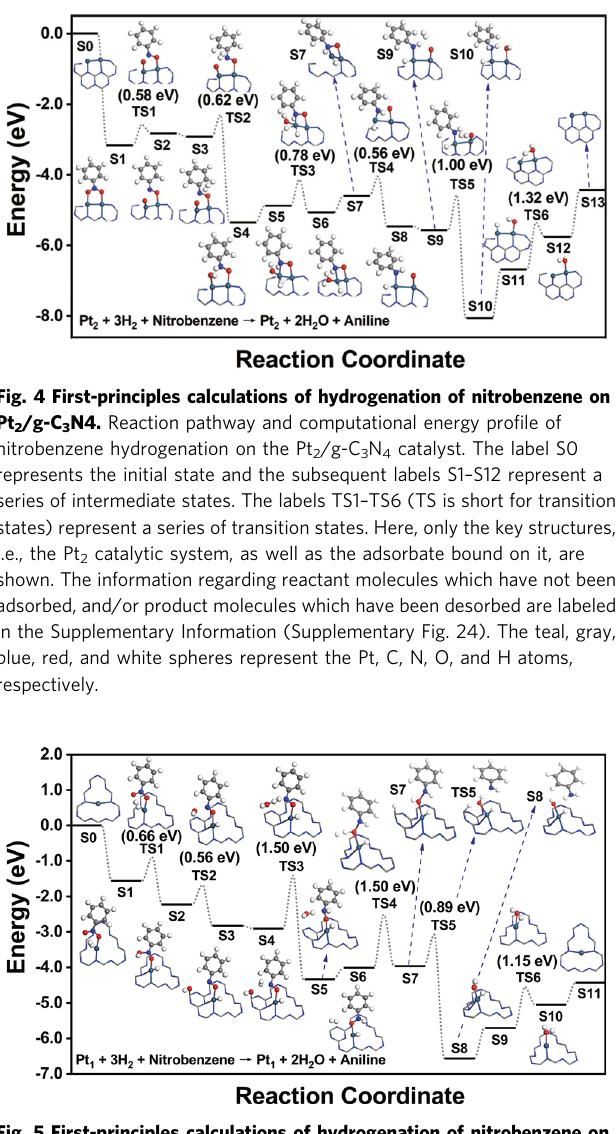
Fig. 5 First-principles calculations of hydrogenation of nitrobenzene on Pt 1 /g-C 3 N4. Reaction pathway and computational energy pro fi le of nitrobenzene hydrogenation on the Pt 1 /g-C 3 N 4 system. The label S0 represents the initial state and the subsequent labels S1 – S10 represent a series of intermediate states. The labels TS1 – TS6 (TS is short for transition states) represent a series of transition states. Here, only the key structures, i.e., the Pt 1 catalytic system as well as the adsorbate bound on it, are shown. The information regarding reactant molecules which have not been adsorbed, and/or product molecules which have been desorbed are labeled in the Supplementary Information (Supplementary Fig. 27). The teal, gray, blue, red, and white spheres represent the Pt, C, N, O, and H atoms, bonds and the elongation of the corresponding bond lengths from 1.25 Å (the corresponding value of an isolated nitrobenzene molecule) to 1.35 Å, both of which lead to the easily breaking of the N – O bonds, and the generation of the unsaturated N and O adsorbates.